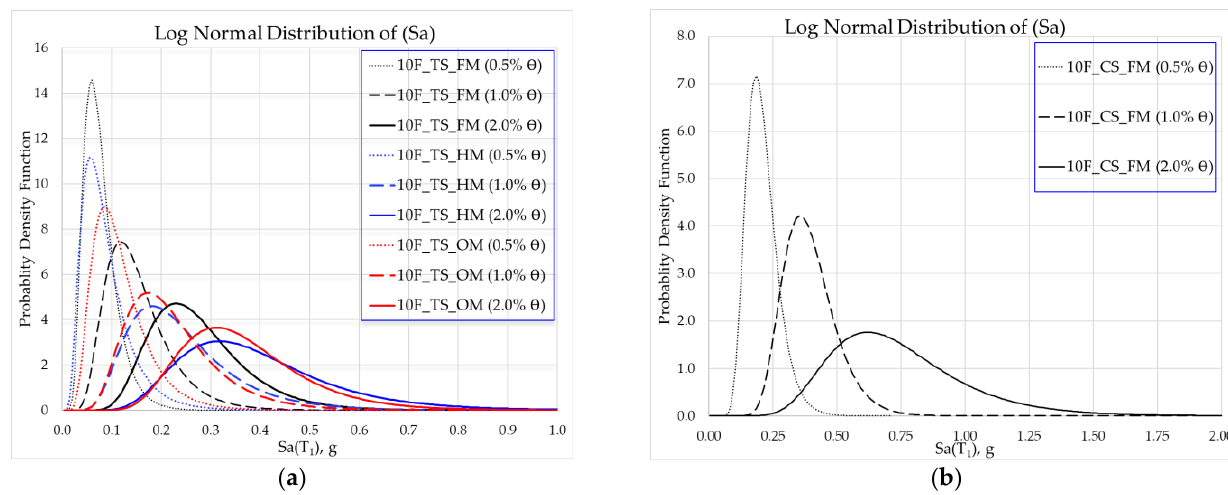
Figure 6. Lognormal distribution of Sa(T 1 ): ( a ) trimmed section ( b ) conventional section.